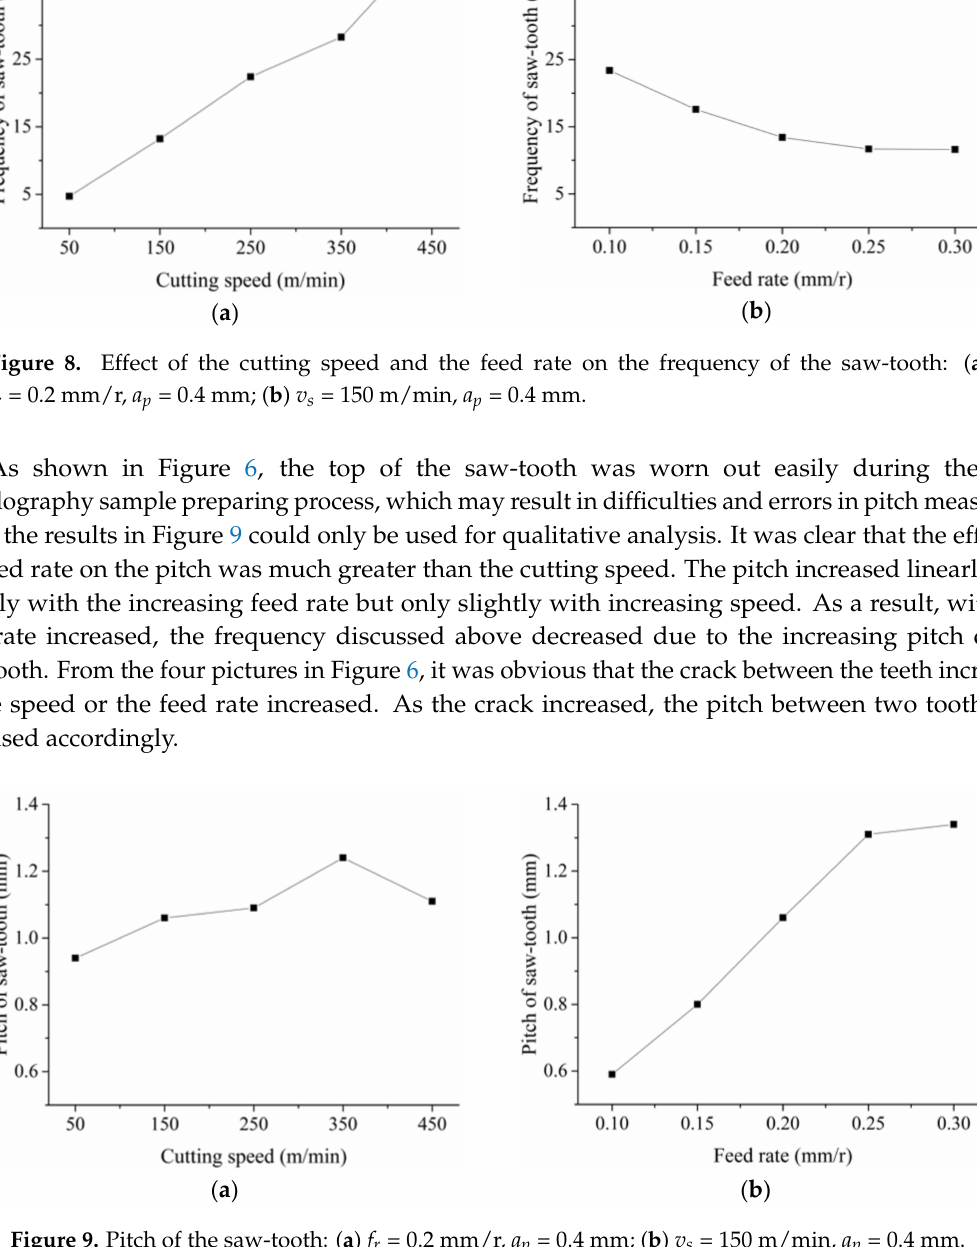
Figure 9. Pitch of the saw-tooth: ( a ) f r = 0.2 mm/r, a p = 0.4 mm; ( b ) v s = 150 m/min, a p = 0.4